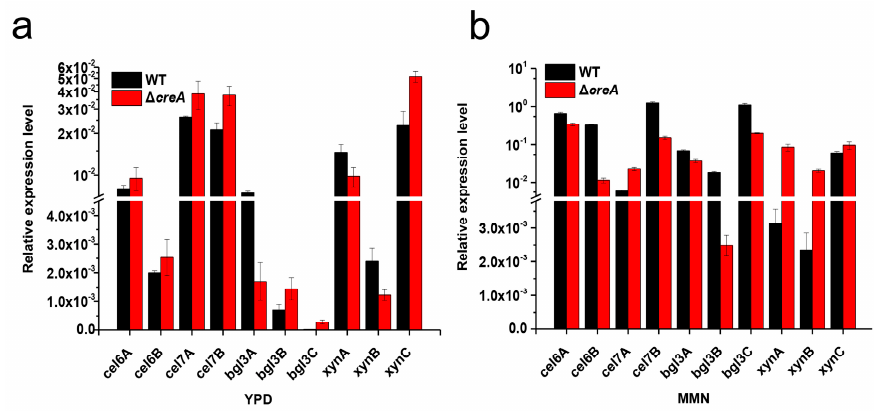
Figure 6. Relative transcriptional level of cellulolytic genes in H. insolens WT and creA disruption mutant under non-inducing ( a ) or inducing ( b ) conditions.